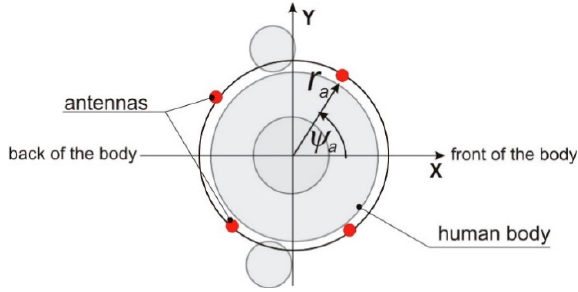
Figure 3. Wearable antenna array—simplified geometry of four-element planar circular array.